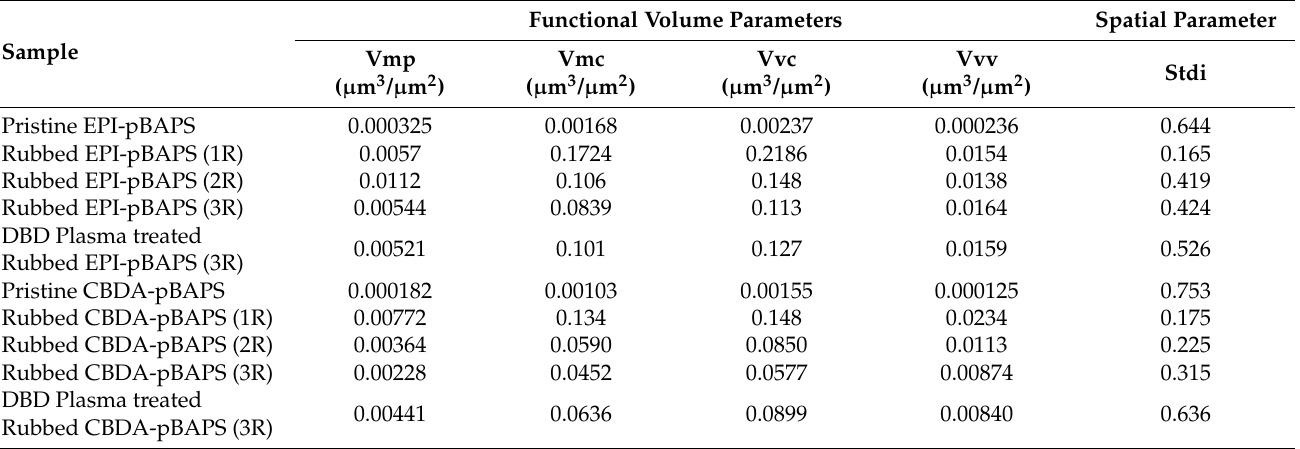
Table 4. Functional volume and spatial parameters calculated from the AFM measurements of the pristine, rubbed along different directions and plasma-treated samples, based on the Abbott–Firestone curves and texture direction representations and graphs with polar coordinates,